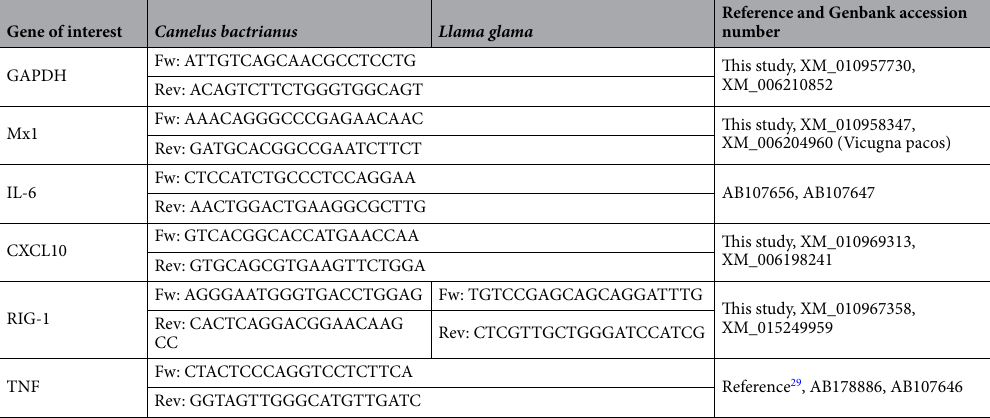
Table 1. List of primers used to identify the ISGs in Bactrian camel and llama AEC cultures.